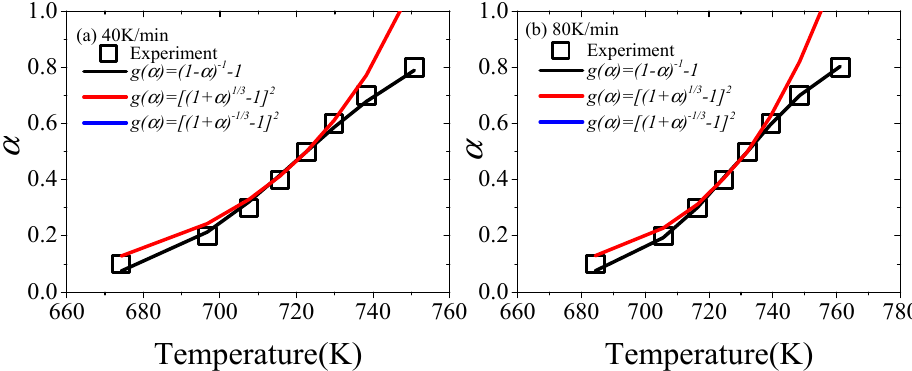
Figure 3. The experimental and theoretical α in the cases of ( a ) 40 K/min and ( b ) 80 K/min.